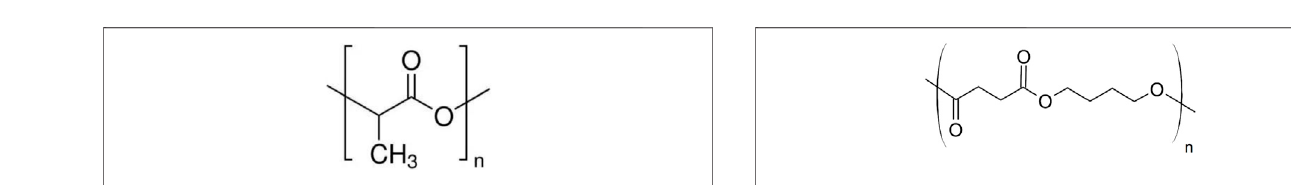
FIGURE 3 | Chemical structure of polybutylene